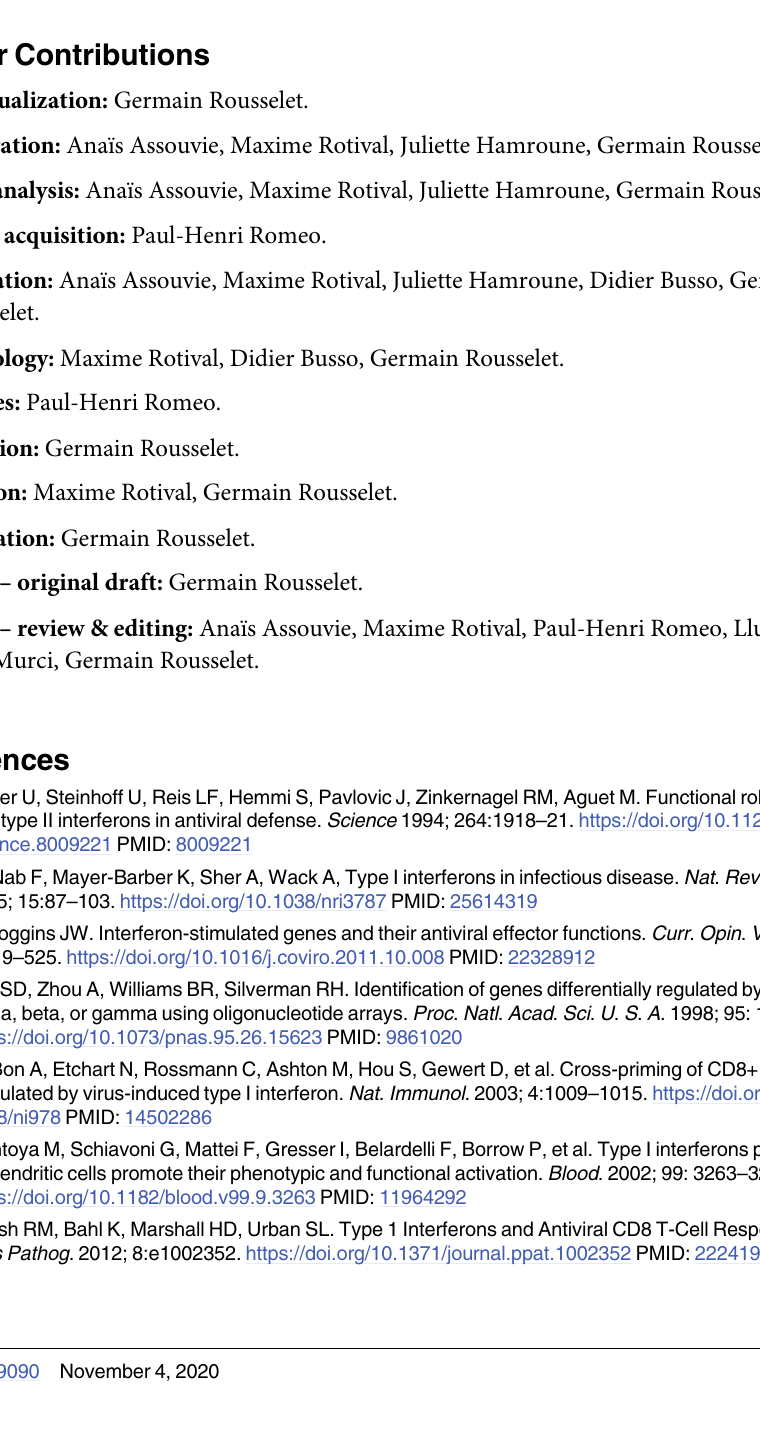
S6 Table. Primers used in the